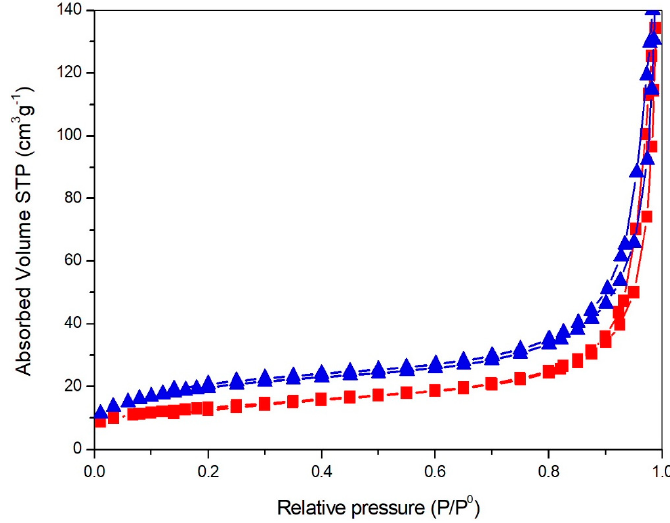
Figure 2. N 2 adsorption/desorption isotherms collected at − 196 °C over samples outgassed overnight at 150 °C, P25 (squares), FSP (triangles).